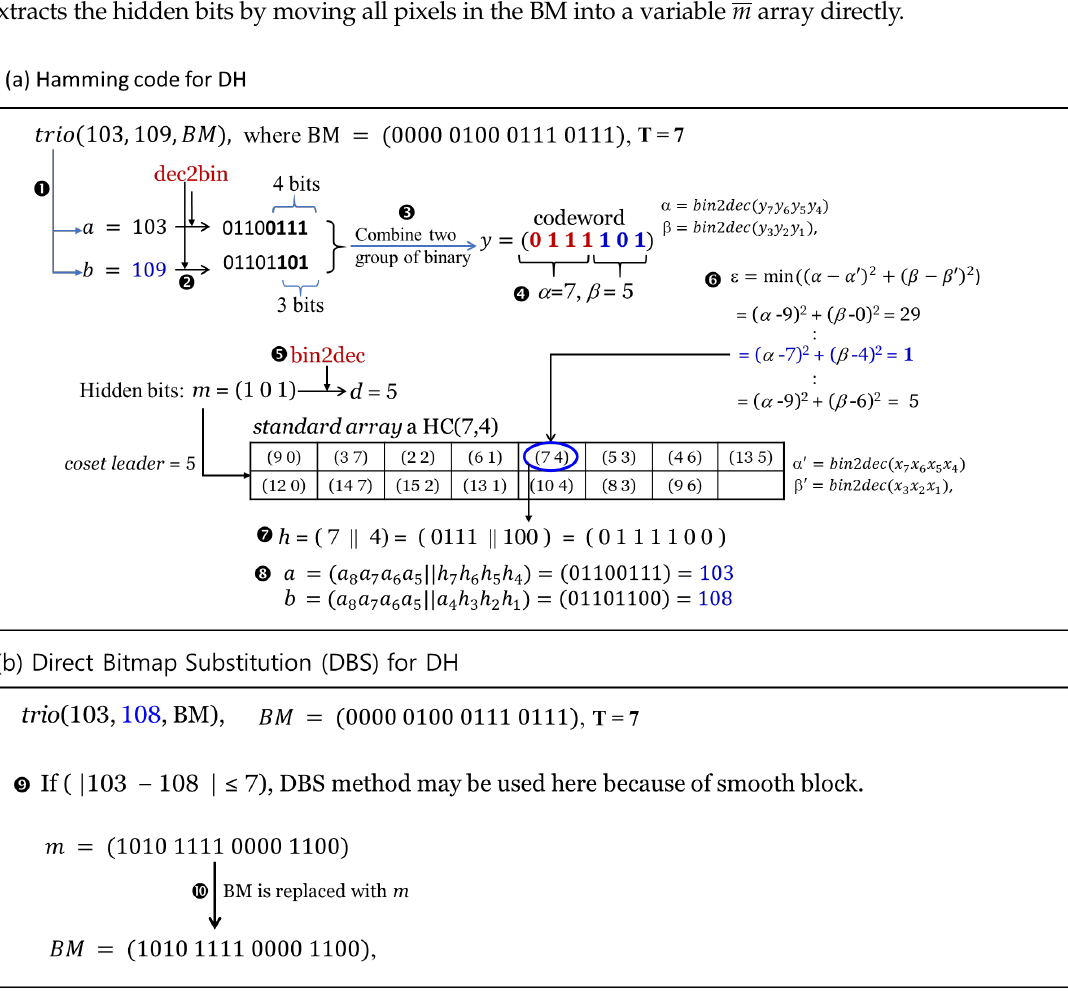
Figure 6. Illustration of data